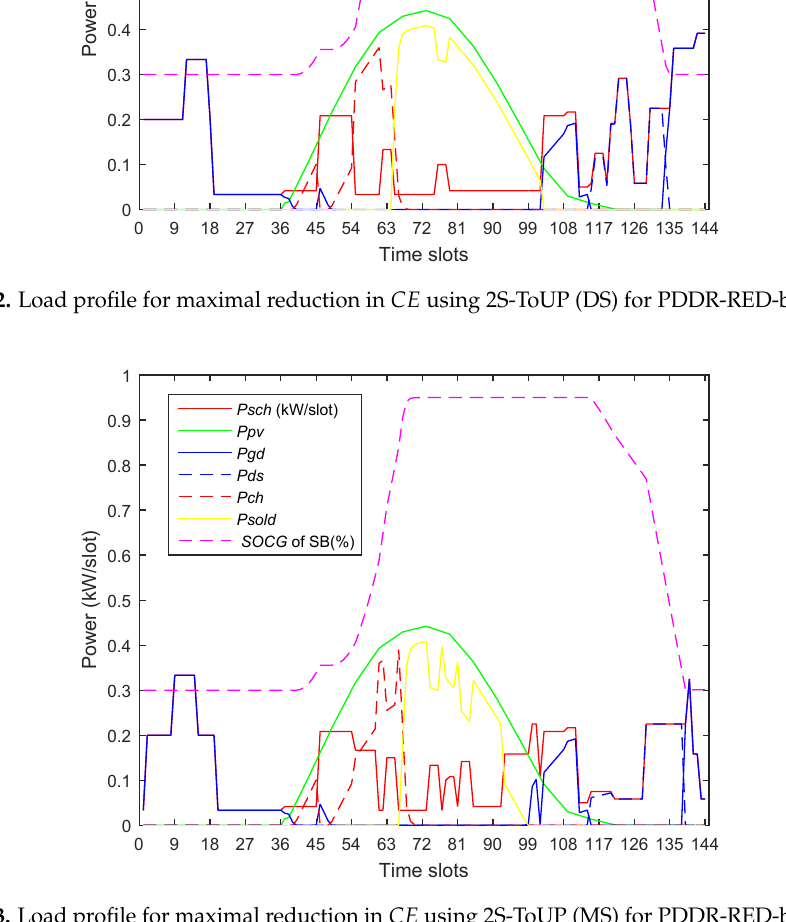
Figure 23. Load profile for maximal reduction in CE using 2S-ToUP (MS) for PDDR-RED-based